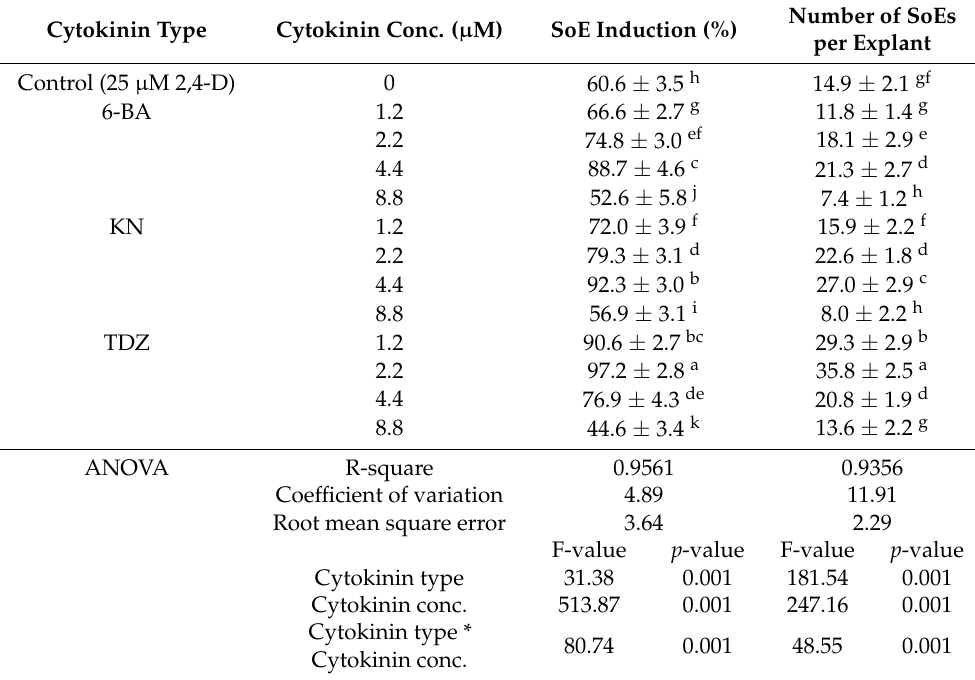
Table 2. Effect of combinations of 25 µ M 2,4-D and cytokinins on SE in C. orbiculata . Cytokinin Type Cytokinin Conc. ( µ M) SoE Induction (%)